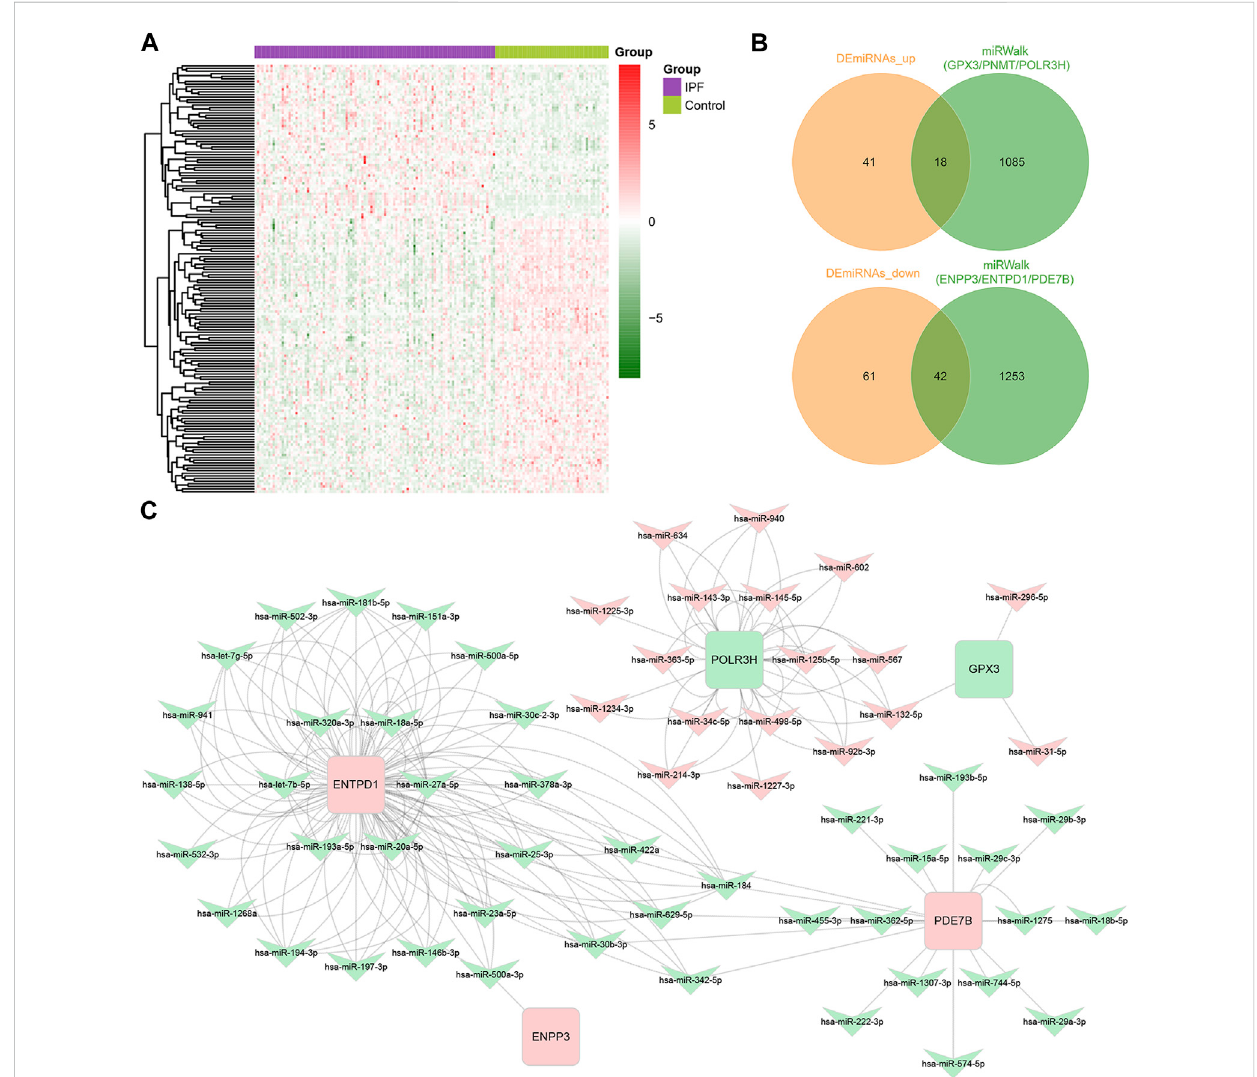
FIGURE 5 Identi fi cation of miRNA-mRNA regulatory networks of Key DEMRGs. (A) Heatmap of DEmiRNAs in GSE32538 (59 upregulated and 103downregulatedDEmiRNAs). (B) VenndiagramshowingtheintersectingmiRNAsbetweenDEmiRNAsandthepredictedmiRNAs. (C) Themetabolism- related miRNA-mRNA regulatory network contained 60 DEmiRNAs and 5 DEMRGs. Red nodes represent upregulated key DEMRGs or DEmiRNAs in IPF lung tissue, and green nodes represent downregulated key DEMRGs or DEmiRNAs in IPF lung